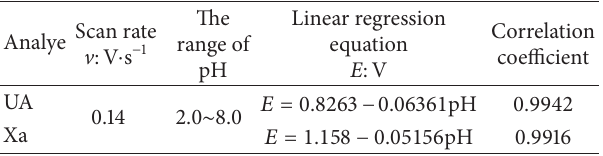
Table 2: The relationship between peak potential and pH of UA and